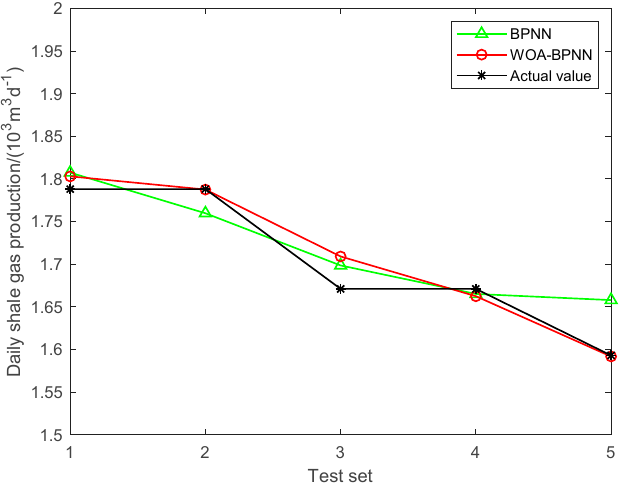
Figure 15. Comparison of actual value, BPNN predicted value andWOA-BPNN predicted value.